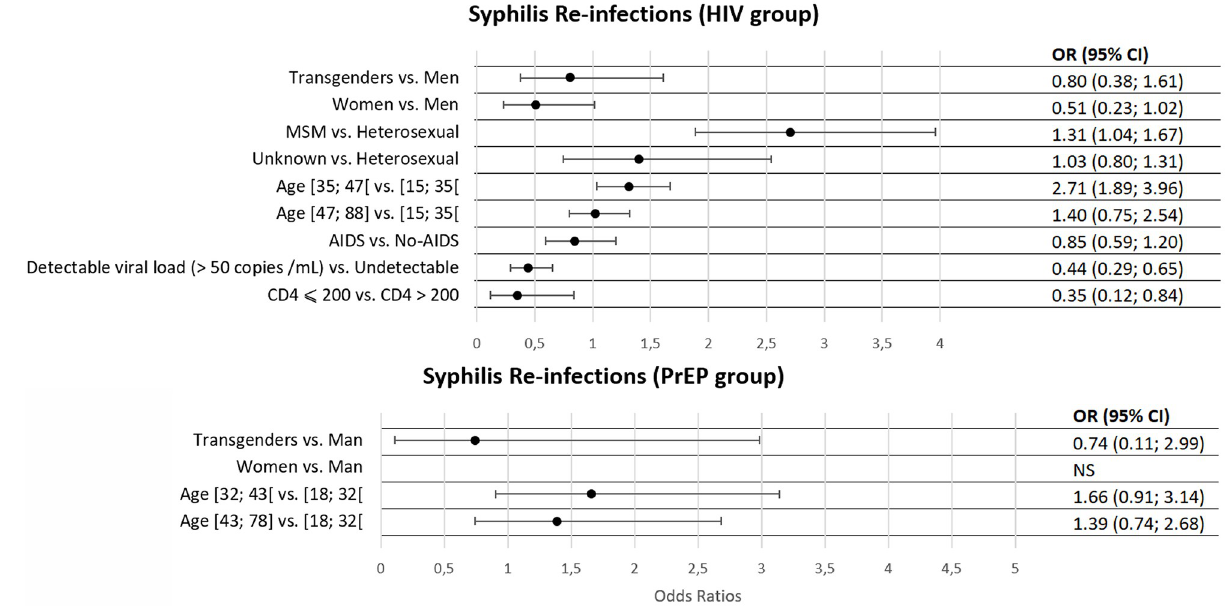
Fig 4. Adjusted odds ratios for factors associated with syphilis re-infection during follow-up among